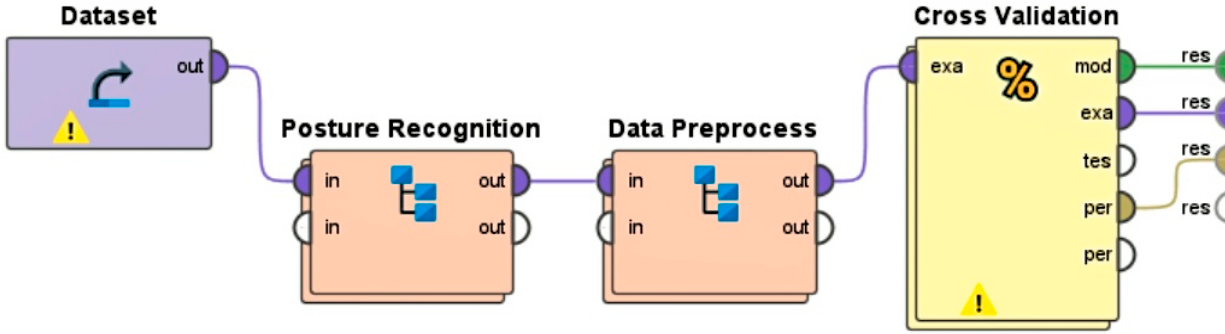
Figure 5. The process that we developed in RapidMiner using the cross-validation approach and the AdaBoost algorithm. The AdaBoost algorithm was a subprocess of the cross-validation operator, as shown in Figure 6a.